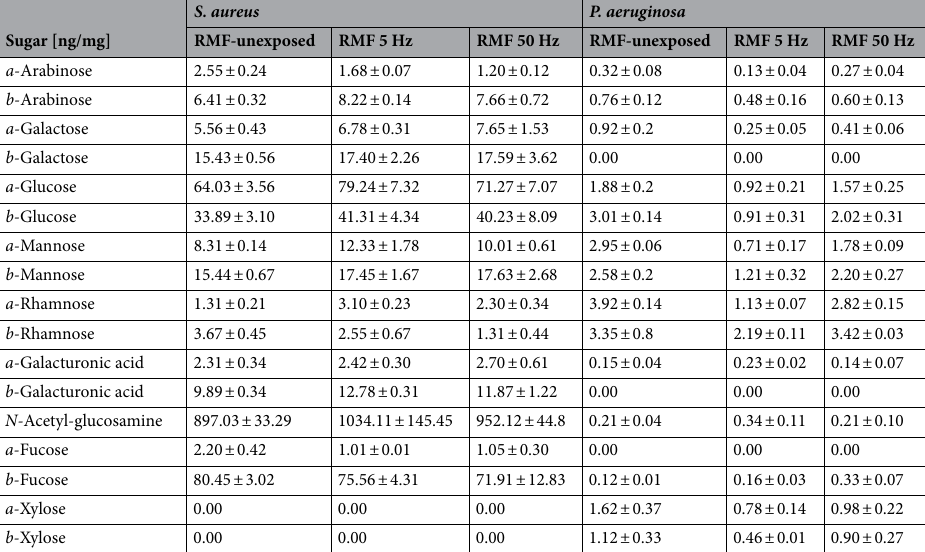
Table 1. The average content of specific sugars [ng/mg of sample] in cell-free S. aureus and P. aeruginosa matrix obtained from biofilms exposed and unexposed to